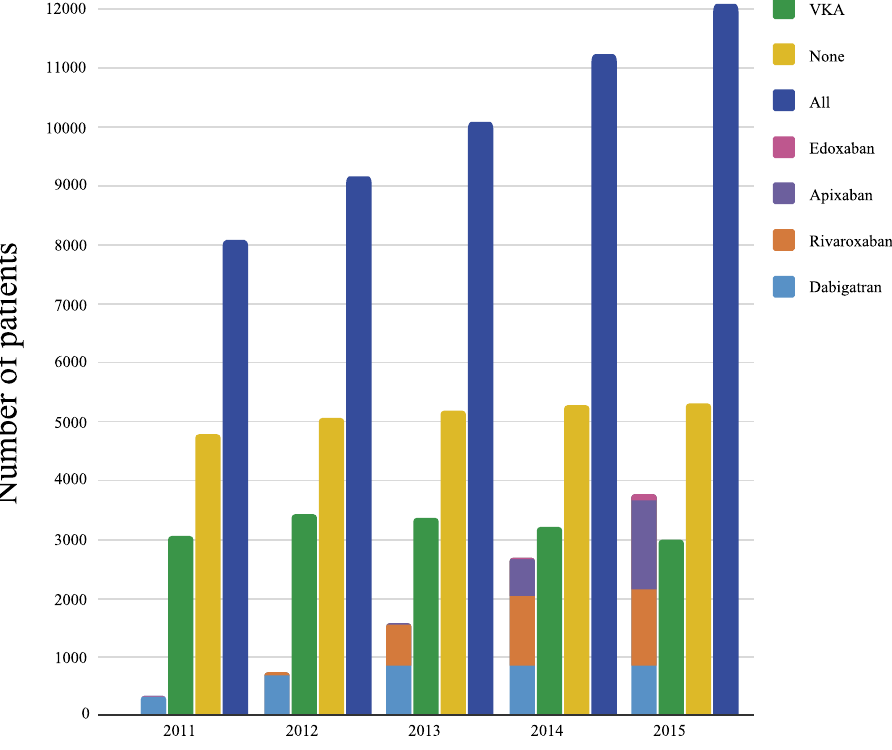
Figure 2. Time trends in the numbers of oral anticoagulant prescriptions. Figure shows time trends in the number of patients who were prescribed VKA, each of the four DOACs, and that of all DOAC-prescribed patients combined, among all. Af patients aged ≥ 65 years. VKA vitamin K antagonist, DOACs direct oral anticoagulants.